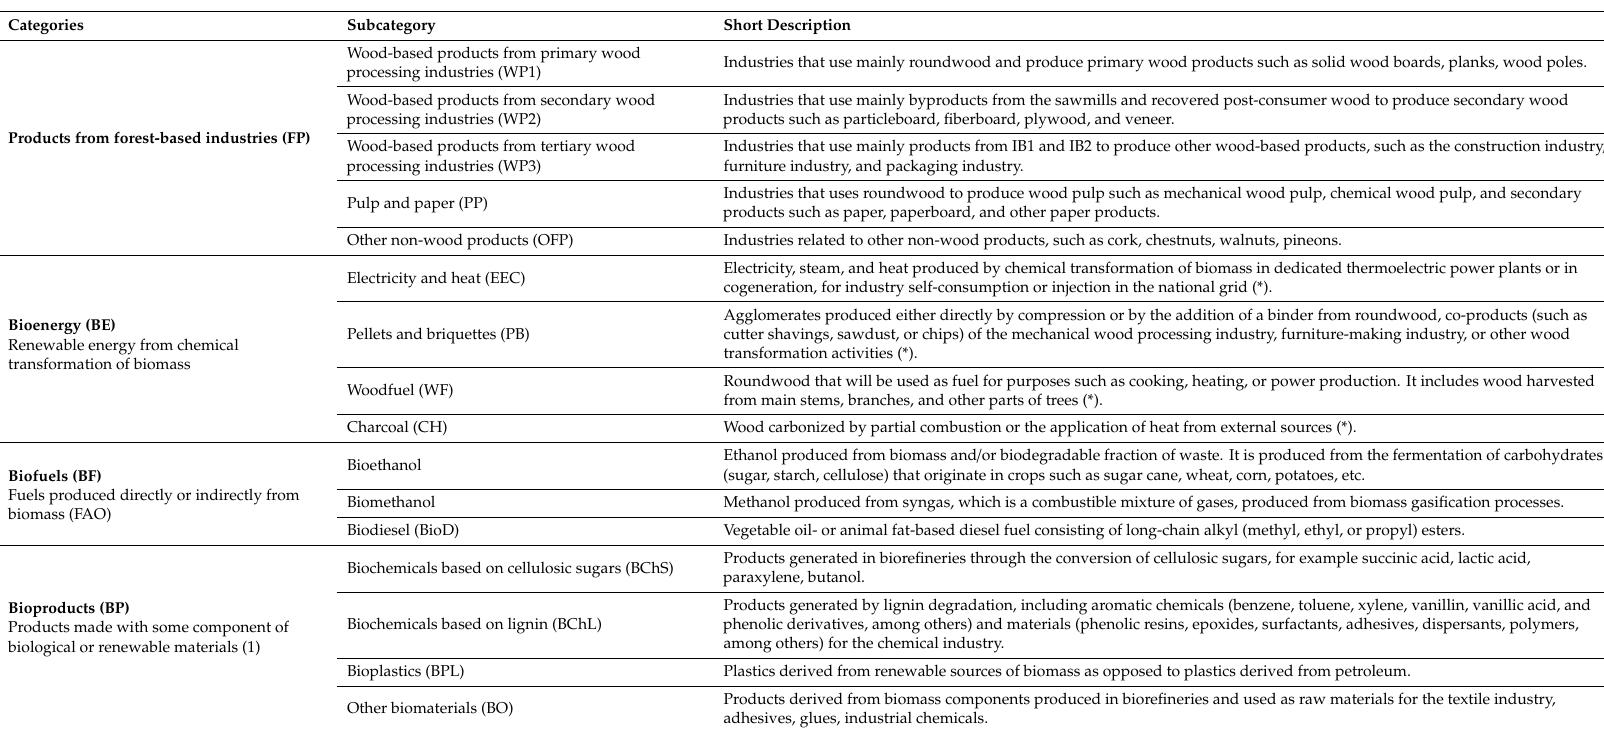
Table 2. Main wood-based biomass uses and applications (definitions adapted for Eurostat-JFSQ are marked with